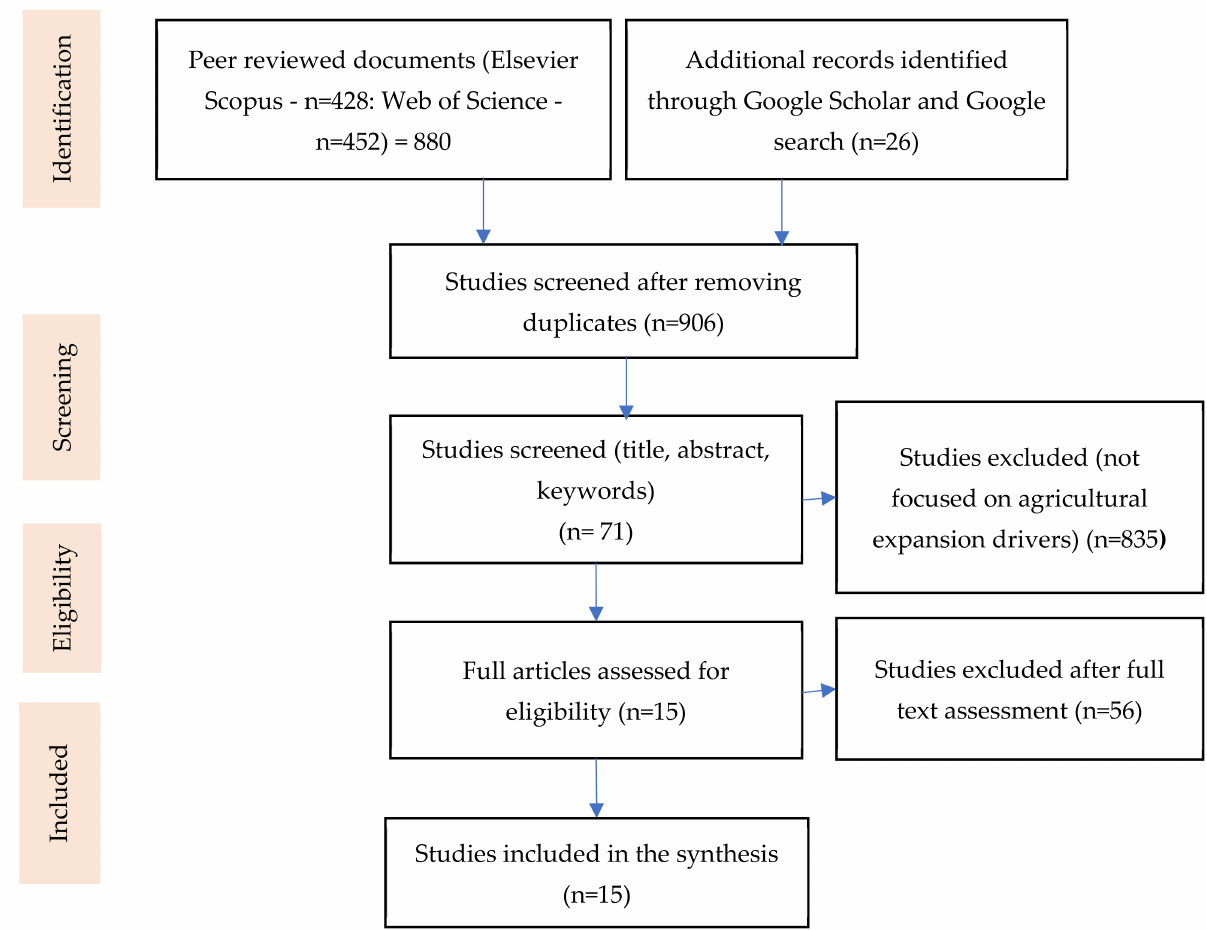
Figure 1. PRISMA flow chart for the systematic review methodology. Adapted from: Moher, Liberati